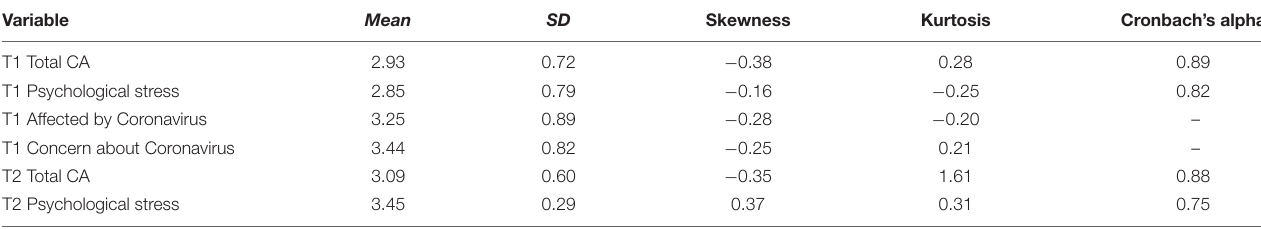
TABLE 5 | Study 2 descriptive statistics and reliability analyses. Variable